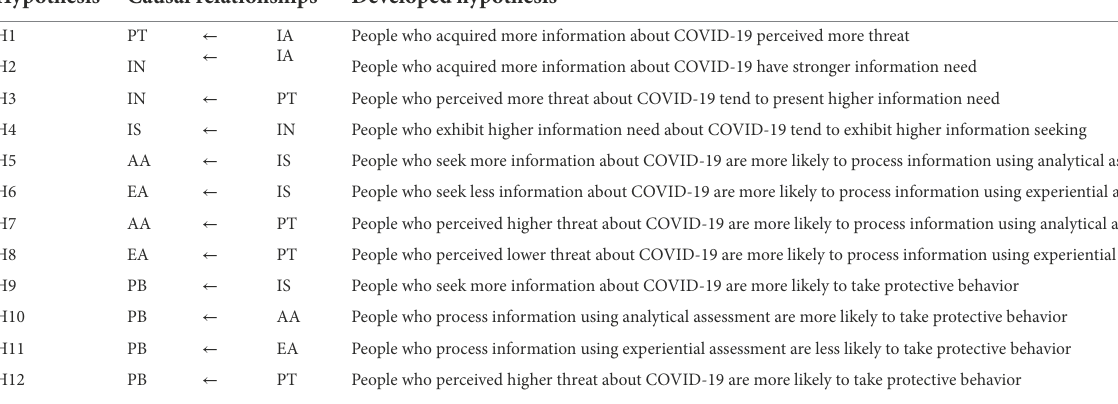
TABLE 1 Developed hypothesis and causal relationships. Hypothesis Causal